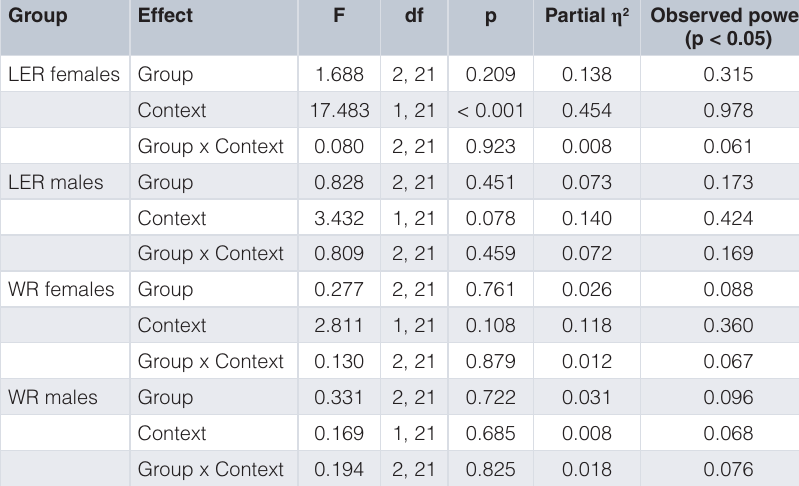
Table 2. Statistical results for Experiment 2